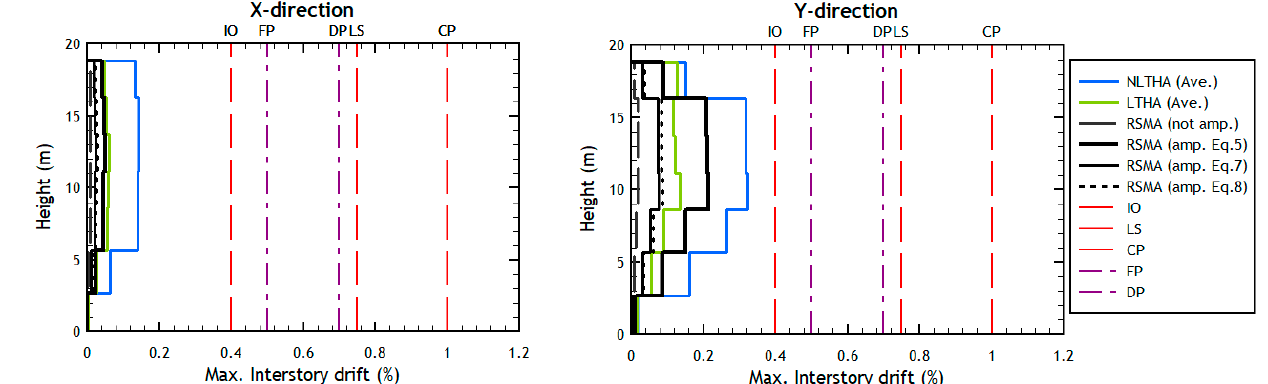
Figure 17. Maximum displacements as predicted by the different analyses.